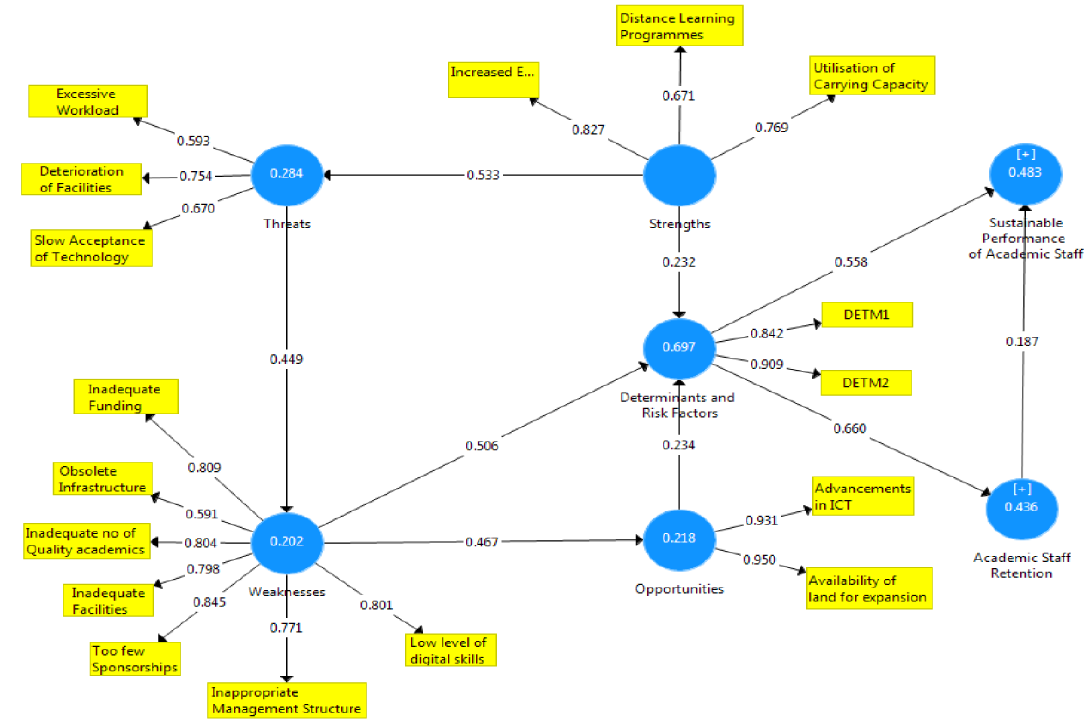
Figure 1. The basic co-efficient algorithms.